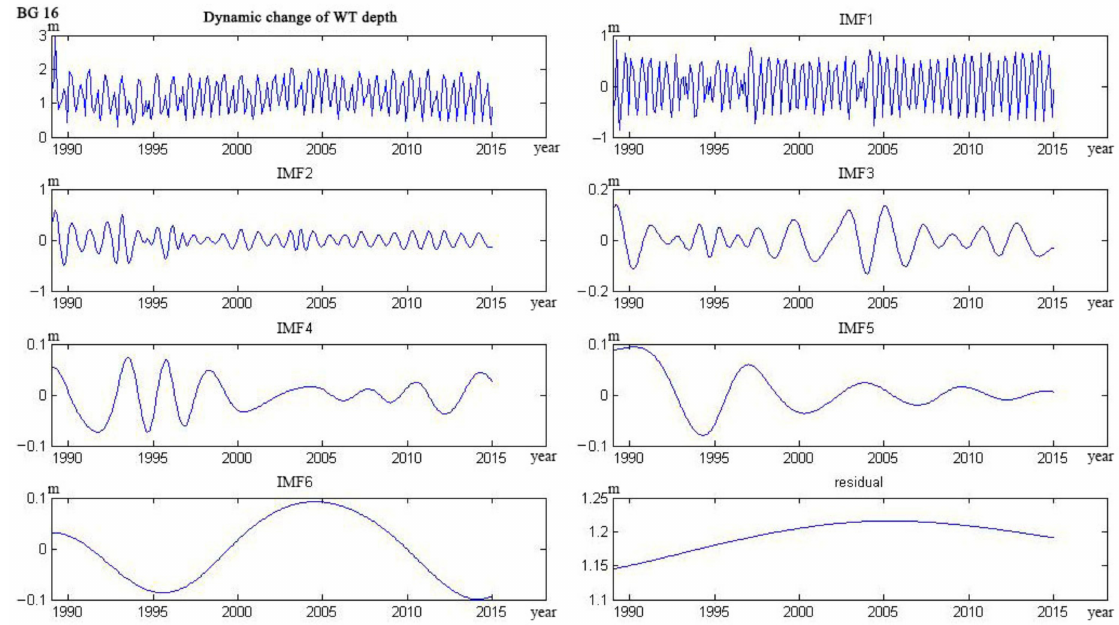
Figure A12. Decomposition of groundwater time series data of well